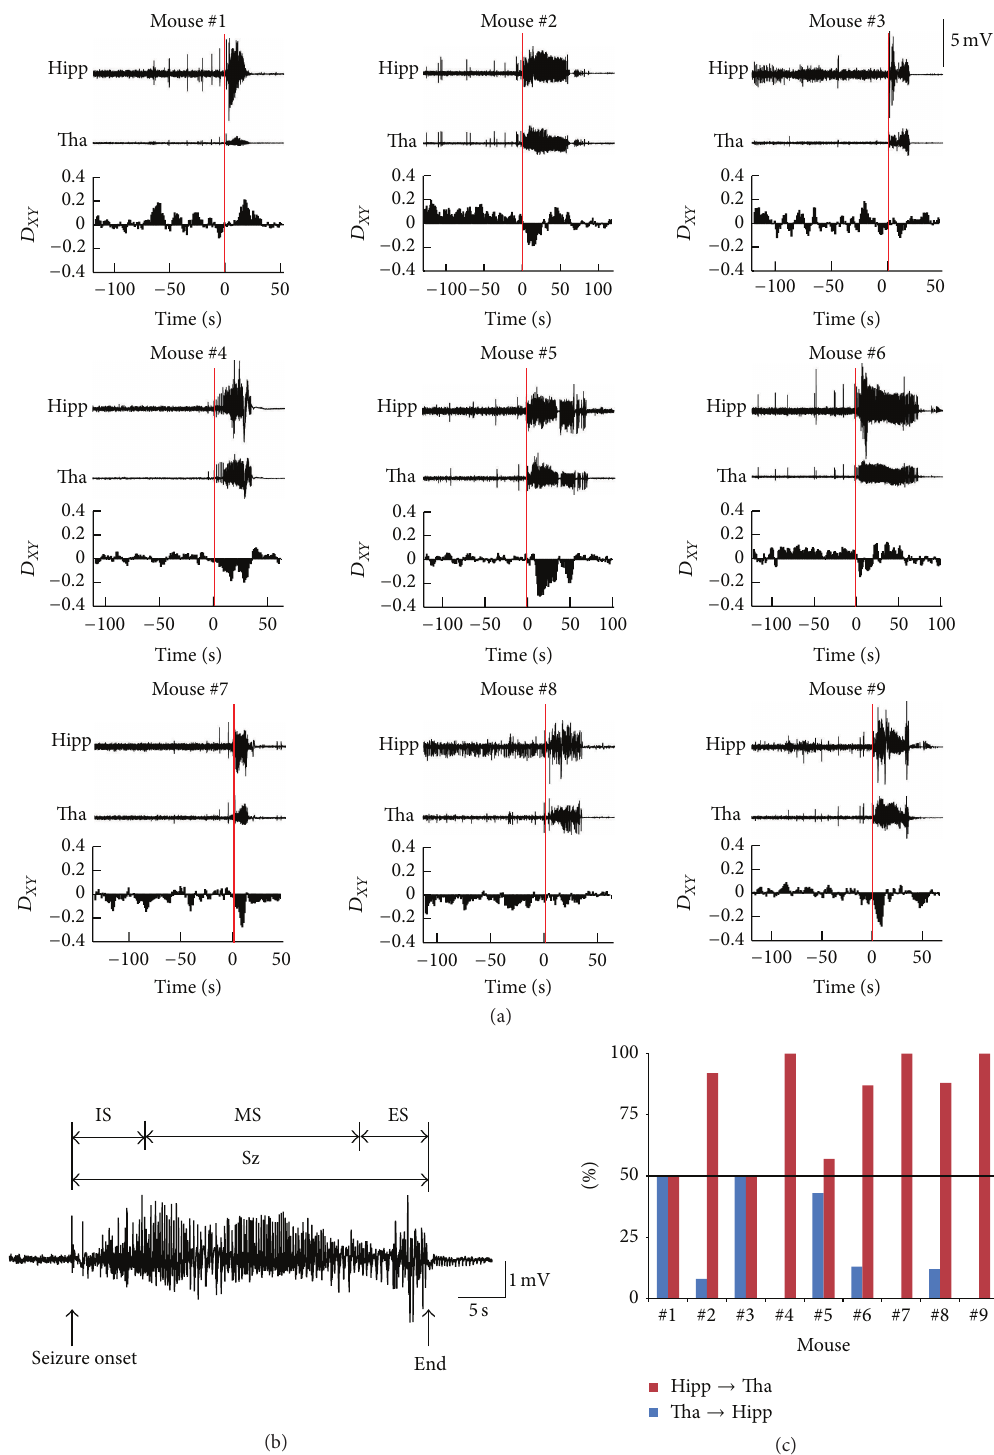
Figure 6: Peri-ictal coupling dynamics between hippocampus and thalamus. (a) Time course of directionality index ( 𝐷 𝑋𝑌 ) between hippocampus and thalamus during the epileptic seizures in 9 mice. The upper two traces show the averaged LFPs from hippocampus and thalamus. The lower trace shows the averaged 𝐷 𝑋𝑌 . The red line indicates the seizure onset time. (b) Time periods’ definition. We divided the Sz period into three parts. The first part is the initiation period of seizure (IS), containing one-fifth of the time course of seizure from the seizure onset. The third part is the end of seizure (ES), containing one-fifth of the time course of seizure immediately before the termination of seizure. The second part is the middle part of the seizure (MS) between the first and the third part. (c) Percentages of coupling direction “hippocampus → thalamus” and “thalamus → hippocampus” during the initiation period of seizure (IS). The black solid line marks the threshold of 50%. Hipp, hippocampus; Tha,